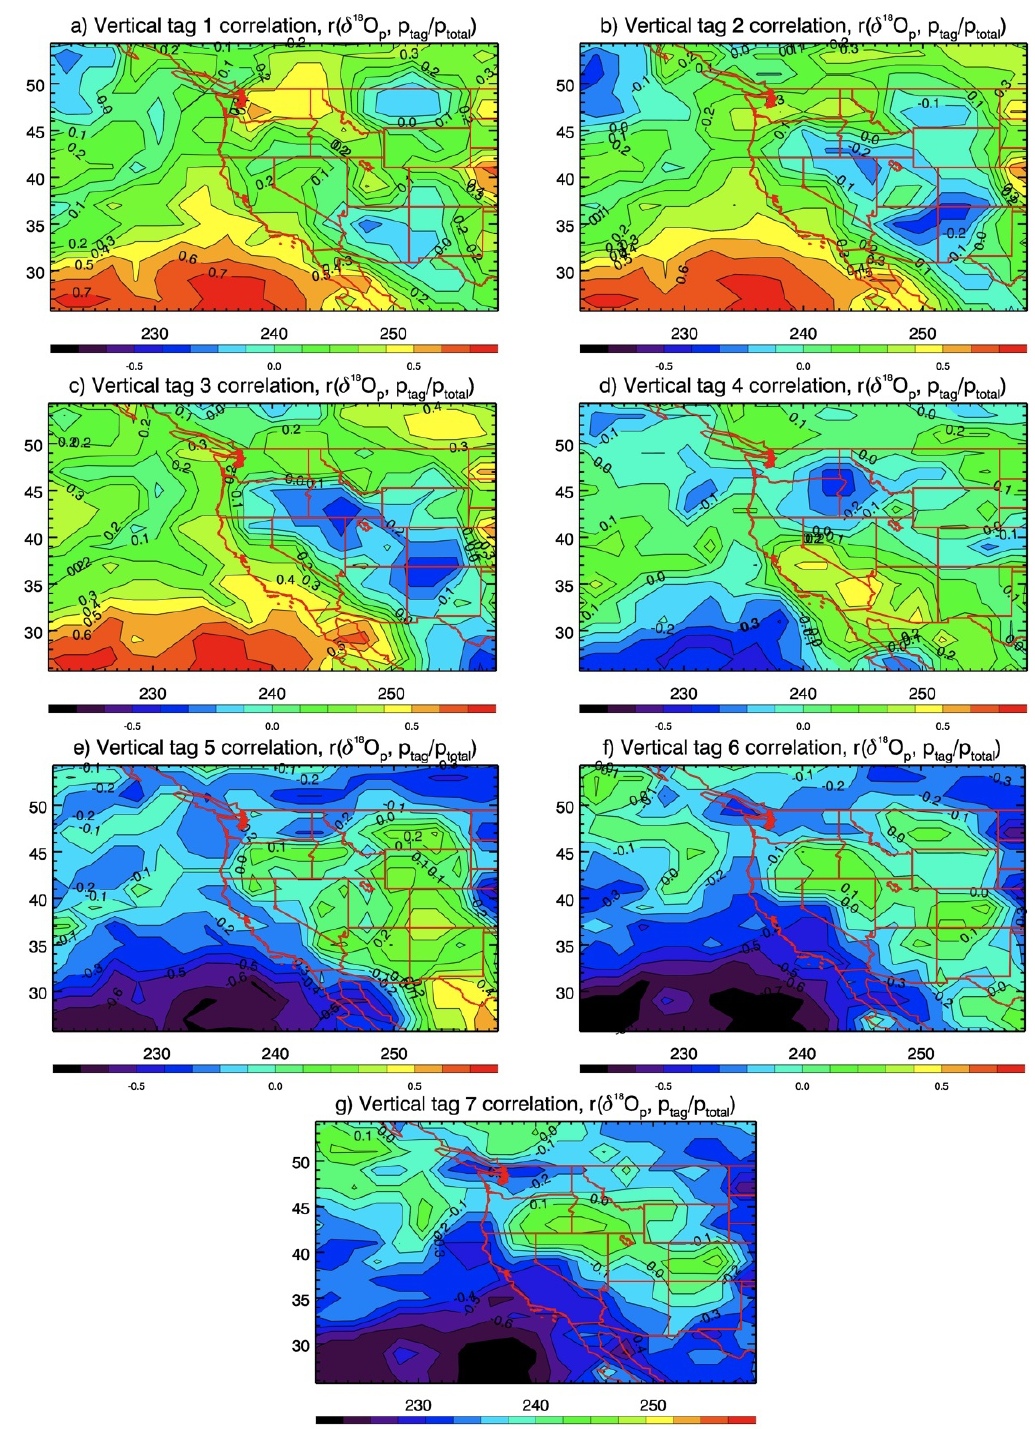
Figure 4. ( a )–( g ) Correlation between interannual δ 18 O precipitation from each of the vertical tags. Correlations with the bottommost tag is shown in panel ( a ) (tag 1); and correlations with higher level tags are shown in panels ( b )–( g ). Contour intervals are 0.1. Absolute values of r above 0.263 are significant above the 95% confidence